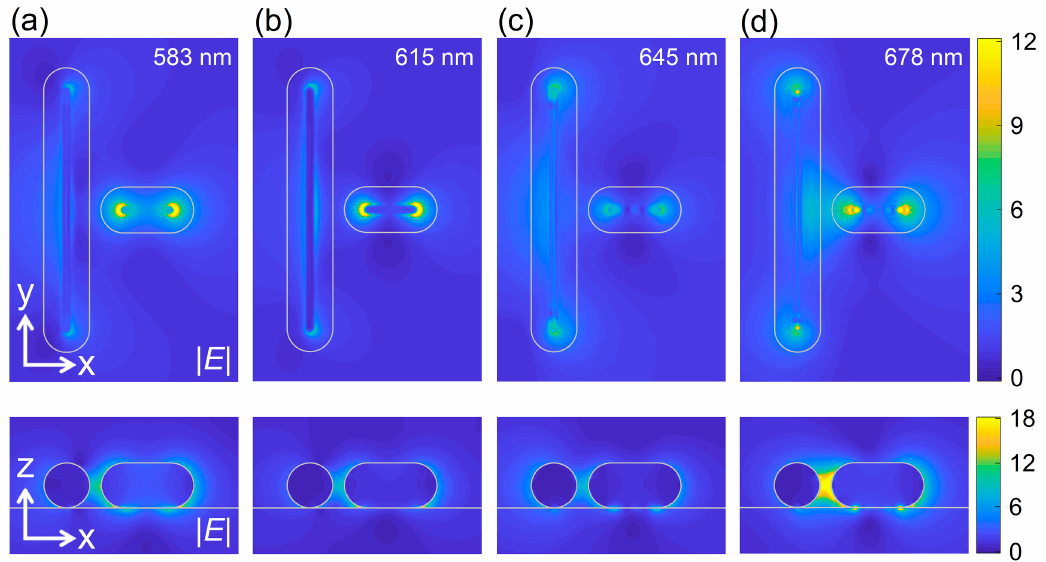
Figure 7. Electric field distributions in the XY (upper panel) and XZ planes (lower panel) calculated for the T-shaped GNR dimer placed on a WS 2 monolayer with L l = 248 nm, L s = 81 nm and w = 10 nm at different wavelengths. ( a ) λ = 583 nm, ( b ) λ = 615 nm, ( c ) λ = 645 nm and ( d ) λ = 678 nm.